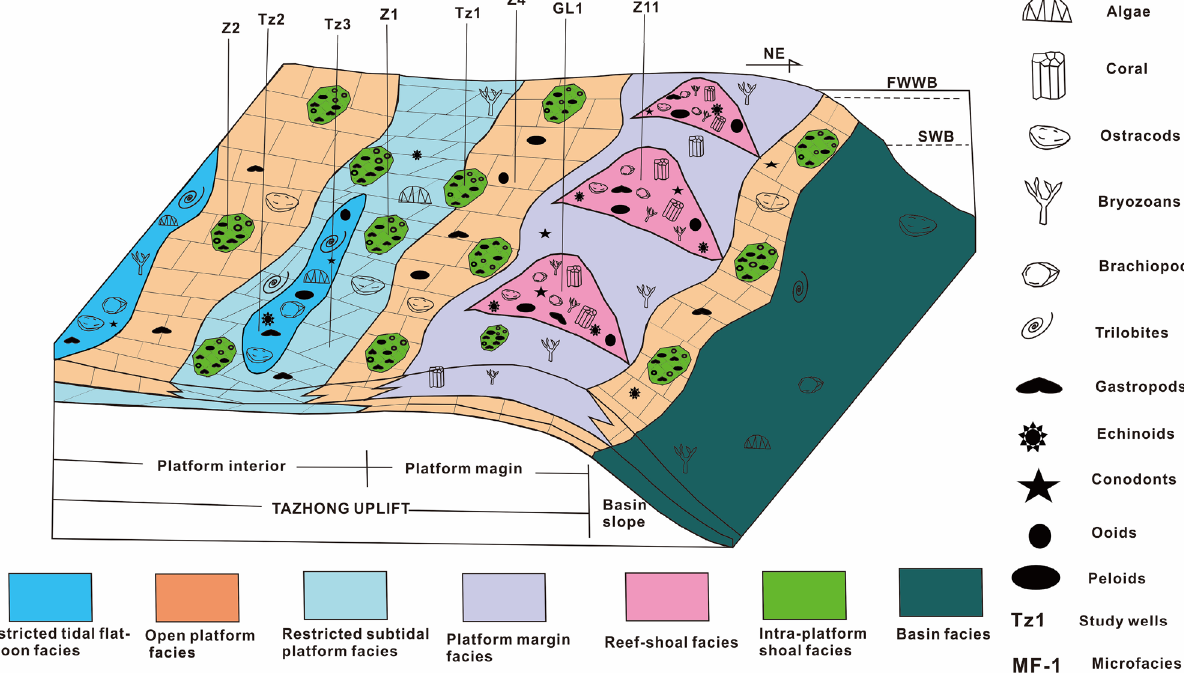
Fig. 9 Depositional model of the coarsening-upward Lower Ordovician carbonate successions in the Tazhong Uplift showing facies distribution within the carbonate platforms and positions of the study wells ( Modified from Gao et al.